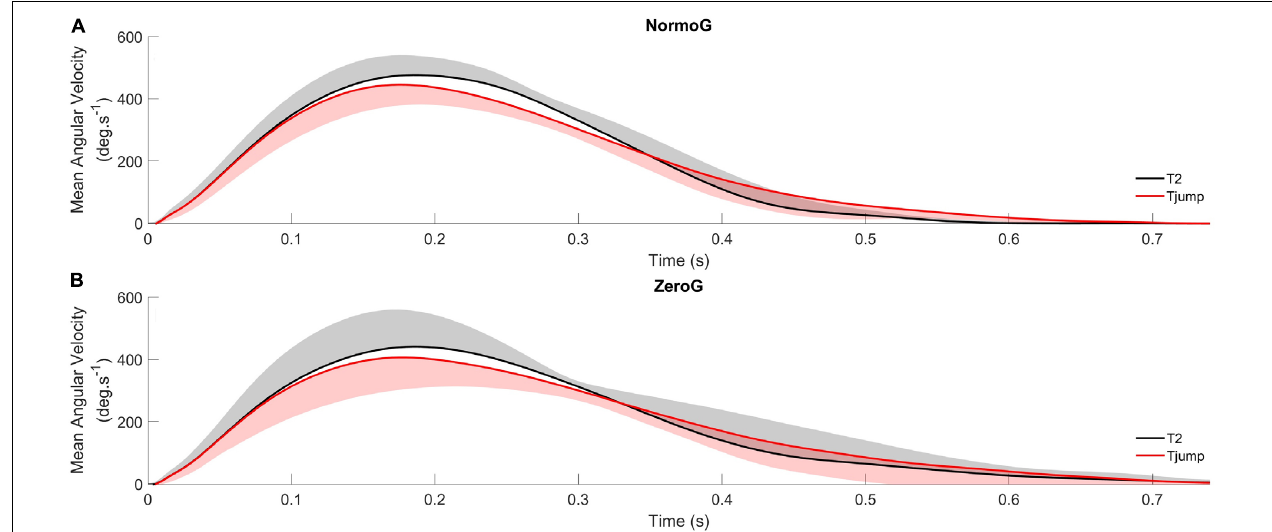
FIGURE 4 | Average angular velocity profiles of arm pointing for T jump and T2 in normogravity (NormoG – Panel A ) and microgravity (ZeroG – Panel B ), illustrating the distinct kinematics between both target.